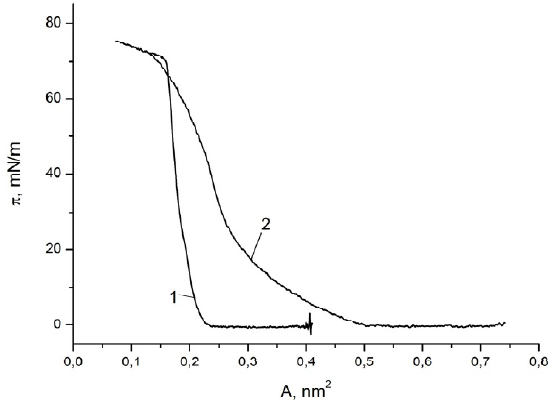
Fig. 6. The compression isotherms of the ODA monolayer on water (1) and the ODA monolayer containing nanoparticles of the nickel